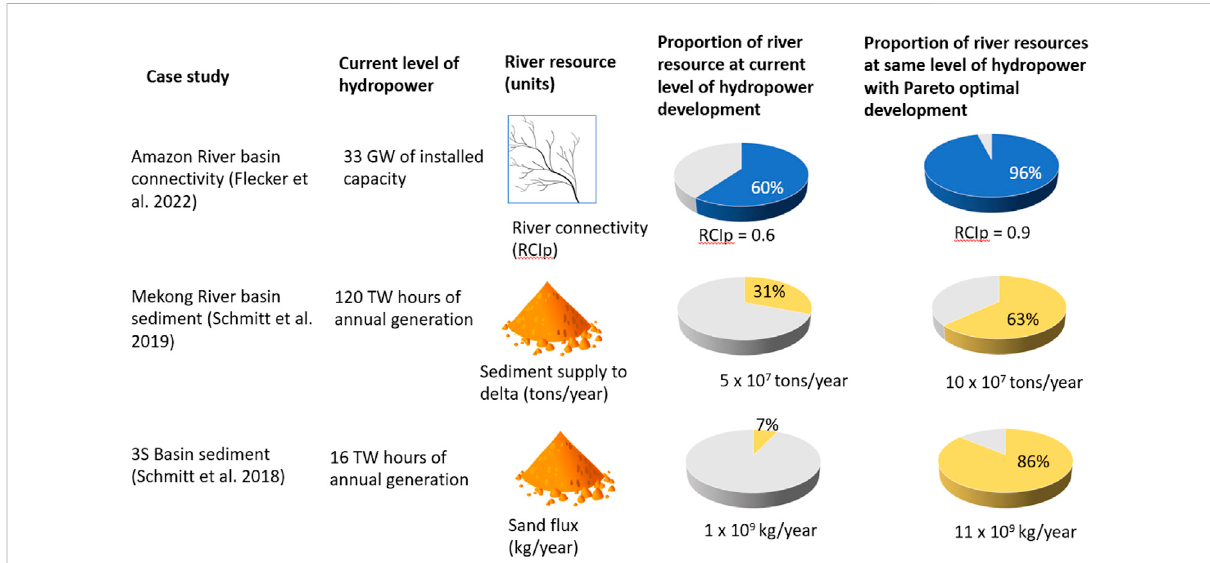
FIGURE 5 Comparing outcomes for river resources for equivalent levels of hydropower development between the actual current level of development and the environmental outcome that could have been achieved through a hydropower system design that identi fi ed Pareto optimal options. For reference, the difference between current outcomes and that which would be possible from Pareto optimal selection for sediment in the Mekong basin (dashed vertical line from Figure 3) is shown in the middle